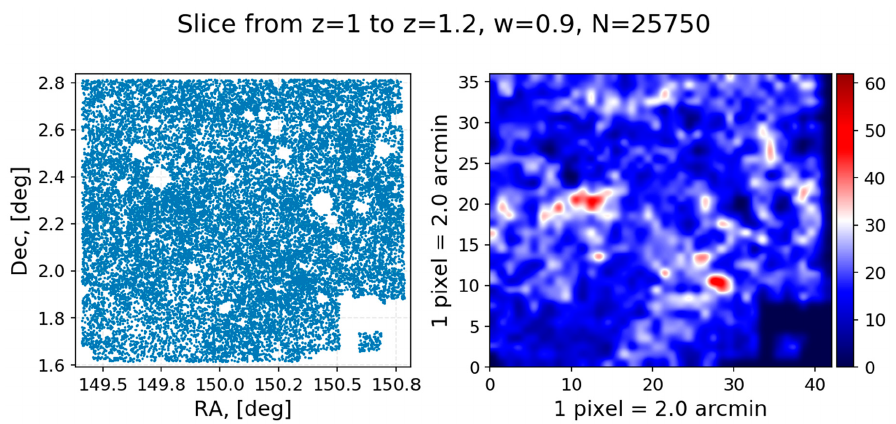
Figure 1. The projection on the sky of 25,750 galaxies from the COSMOS2015 catalogue in the range 1.0 < z < 1.2 with the error σ ( z ) < 10%. The left angular map shows galaxies as points. The right angular map is gaussian interpolation in 36 × 42 pixels (each of which is equal to 2 squared minutes) plotted by using the matplotlib.pyplot library. The color palette shows the galaxy count in one